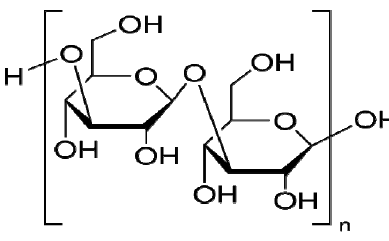
Figure 1. Structural formula of the Laminarin from Laminaria digitata